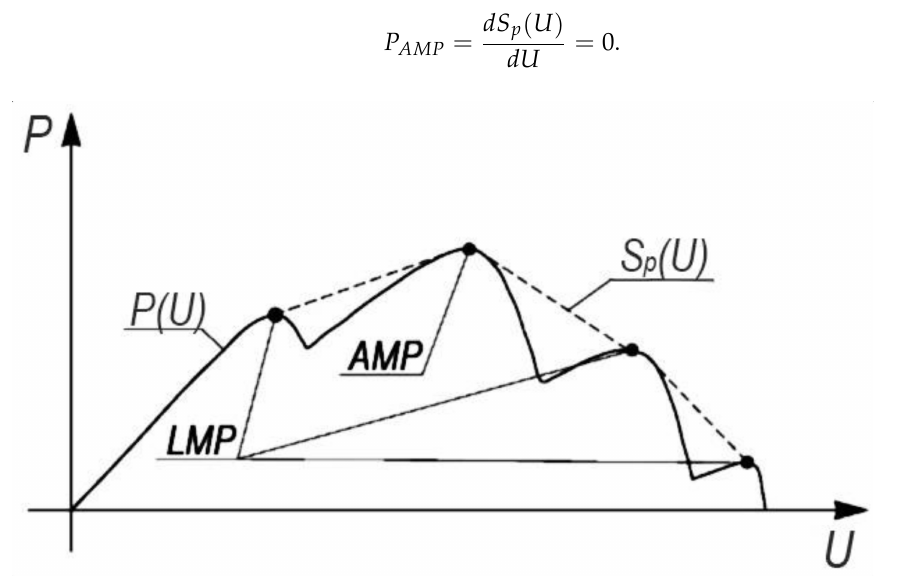
Figure 4. Power characteristic of an unevenly illuminated array of solar